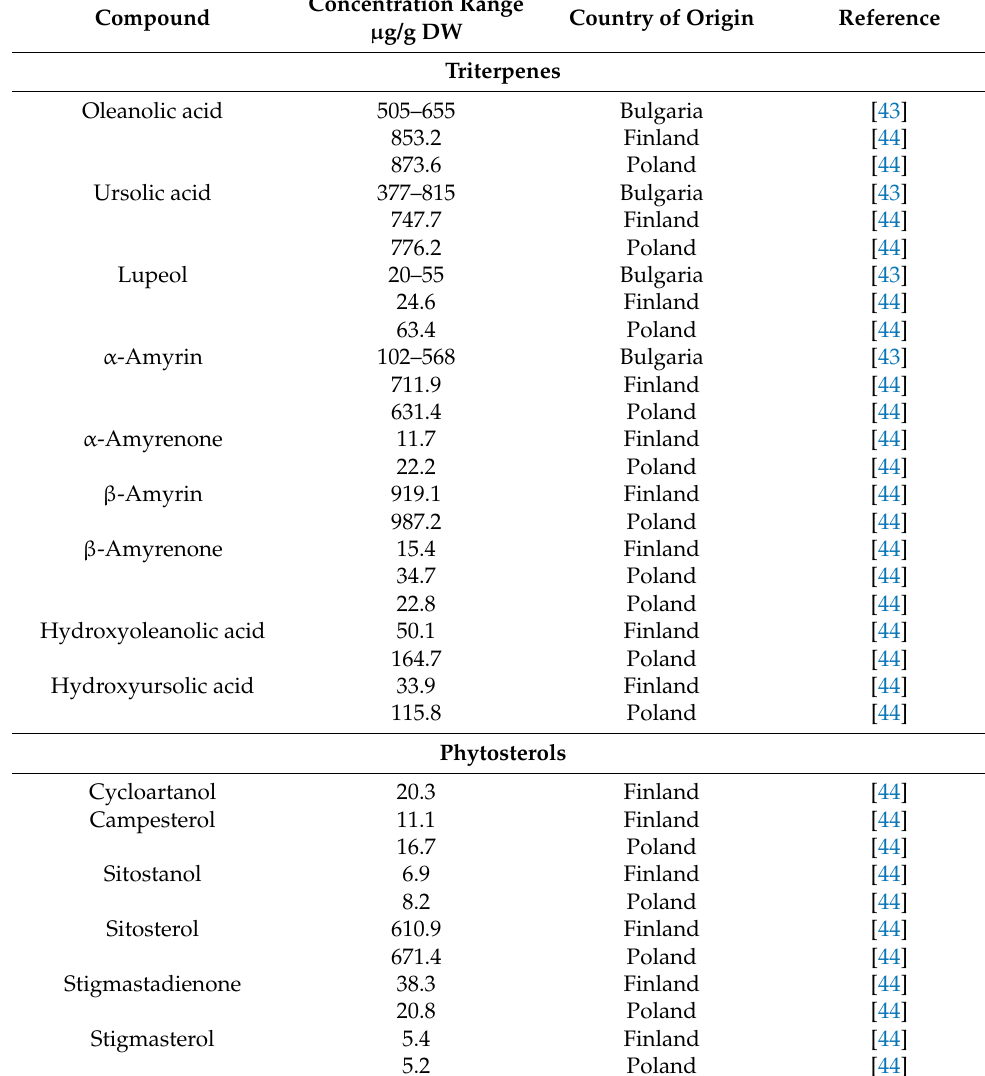
Table 6. Triterpenes and phytosterols identified in bilberry